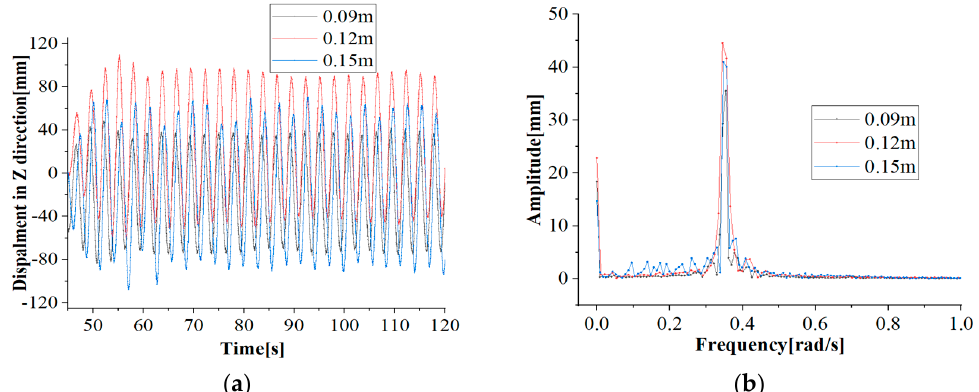
Figure 21. Heave response of the pedestal with different wave heights at 0.30 Hz. ( a ) Heave; ( b ) heave frequency domain curve.